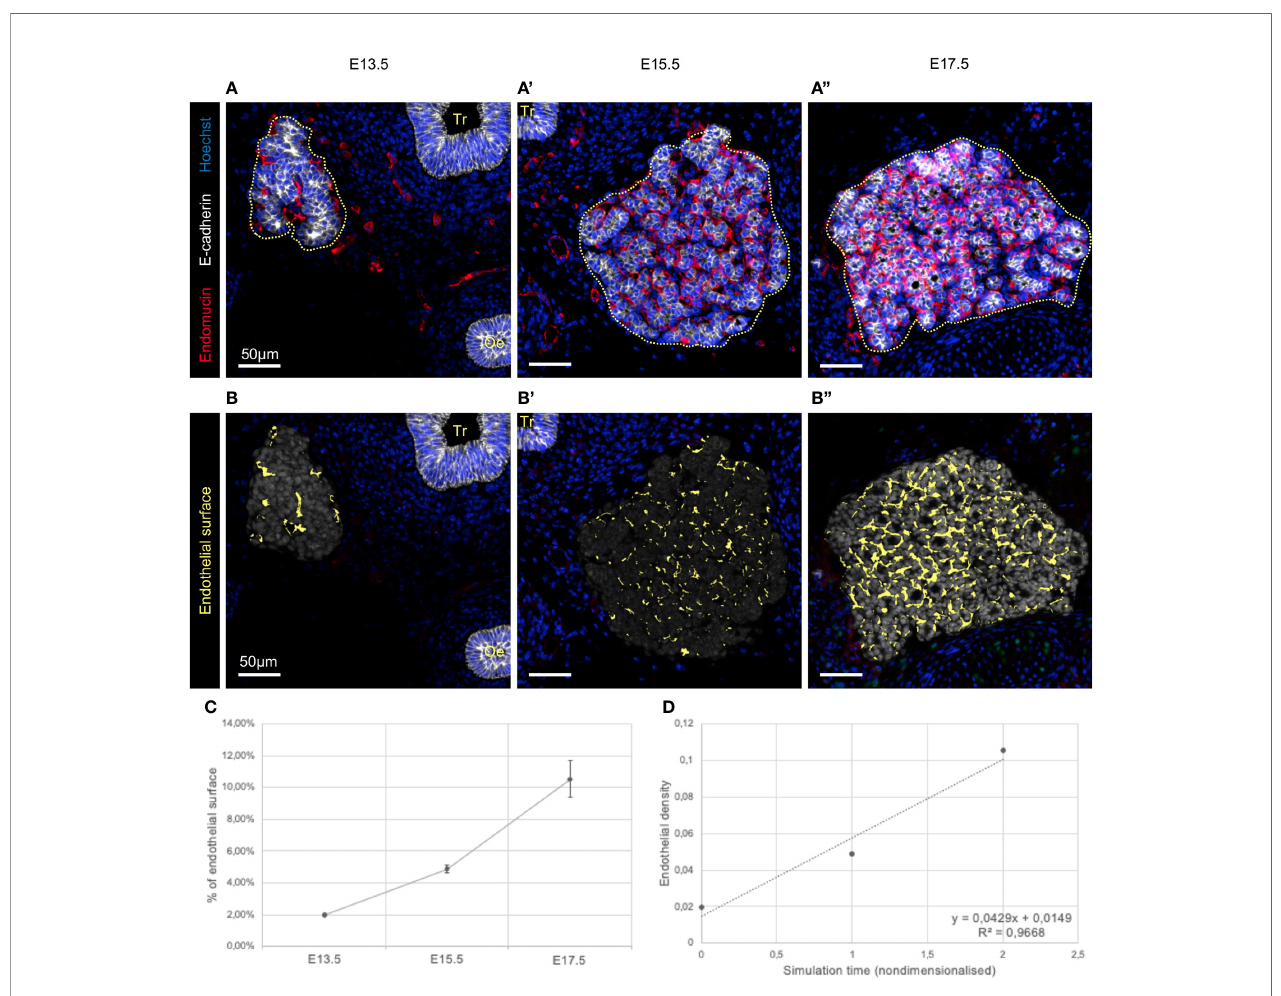
FIGURE 4 | Visualisation and quanti fi cation of endothelial cells in developing thyroid at three different embryonic stages. (A – A ’’ ) Immunolabelling of epithelial cells in white (E-cadherin), and endothelial cells in red (Endomucin). Nuclei are stained in blue (Hoechst). Tr, trachea; Oe, oesophagus. (B – B ’’ ) Endothelial cell within the analysed region of interest (in grey) were coloured in yellow using HALO. (C) Percentage of endothelial cell in the region of interest (n = 3). (D) Endothelial density dynamics in the embryonic thyroid. Both axes are nondimensionalised by using (y) a cell area density (dimensionless), and (x) replacing the embryonic days by the time elapsed between two measures (here